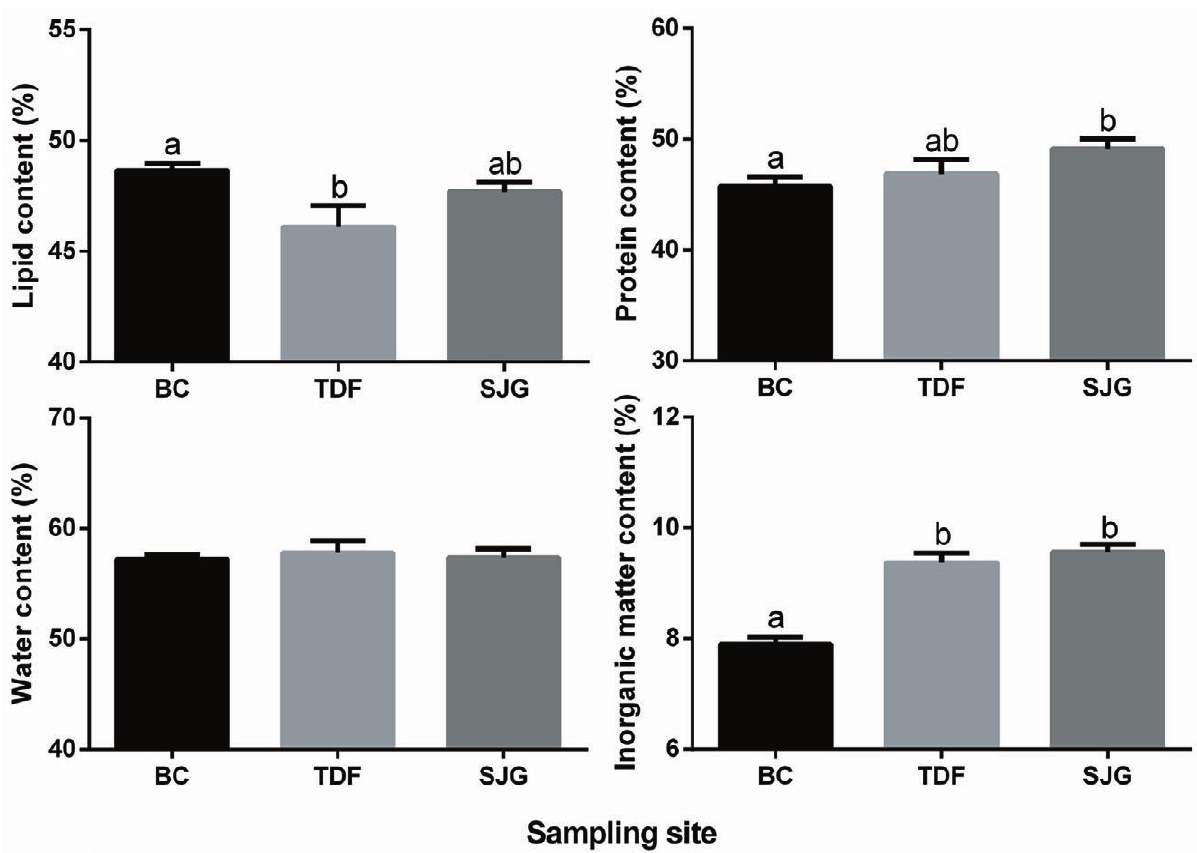
Fig. 5. – Lipid, protein, water and inorganic matter content in egg mass of L. santolla (mean±SE) from the Beagle Channel (BC), Tierra del Fuego (TDF) and San Jorge Gulf (SJG). Different letters indicate significant differences between sites (ANOVA and Tukey, p<0.05; or Kruskal Wallis and Dunn, p<0.05).